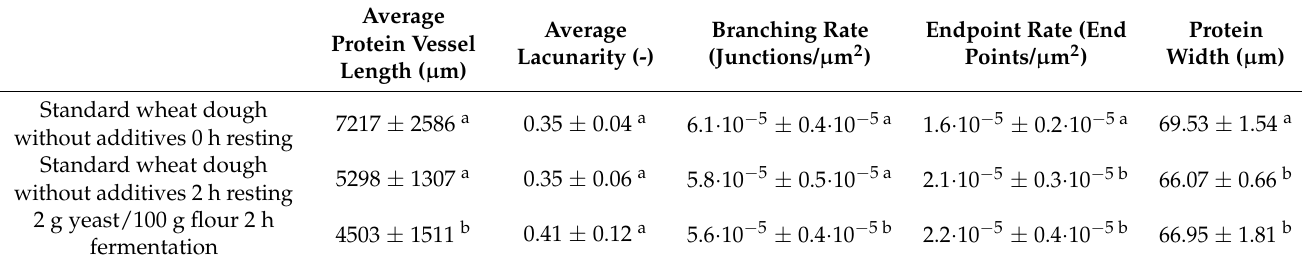
Table 1. Mean values of PNA results. The dough samples were stained with Rhodamine B using the bulk water technique and analysed by CLSM with 60 × magnification. (n = 3, X ± STD). Average Protein Vessel